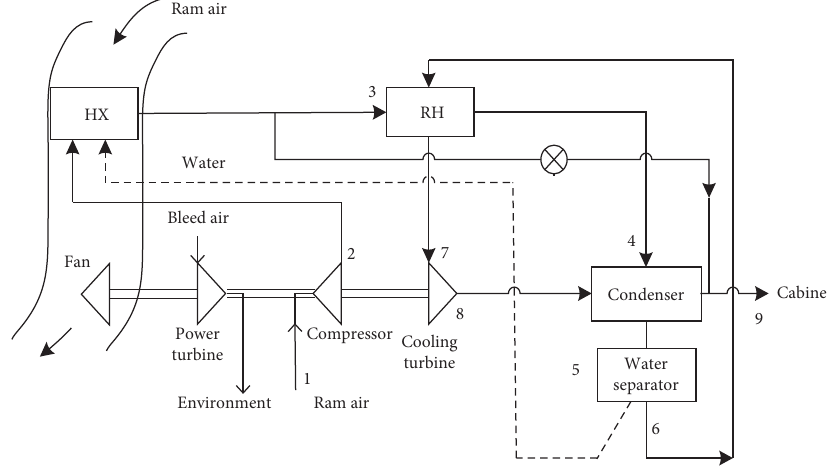
Figure 1: Environment control system driven by a power turbine.